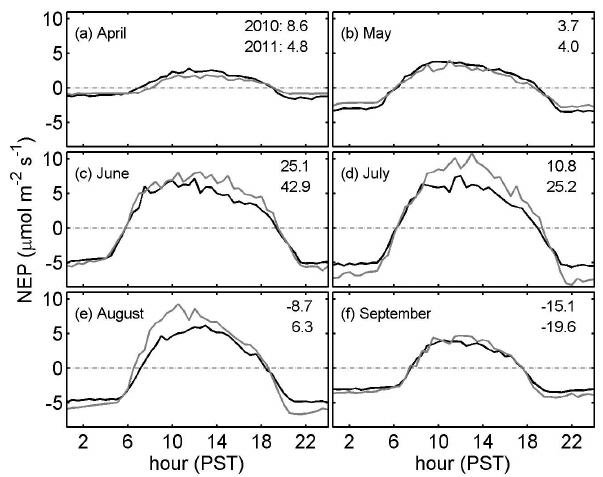
Fig. 4. Ensemble-averaged diurnal net ecosystem production (NEP) during the growing season of 2010 (black lines) and 2011 (grey lines) showing (a) April (b) May (c) June (d) July (e) August and (f) September. Monthly NEP values for the two years shown in the panels are in gCm − 2 month − 1 .